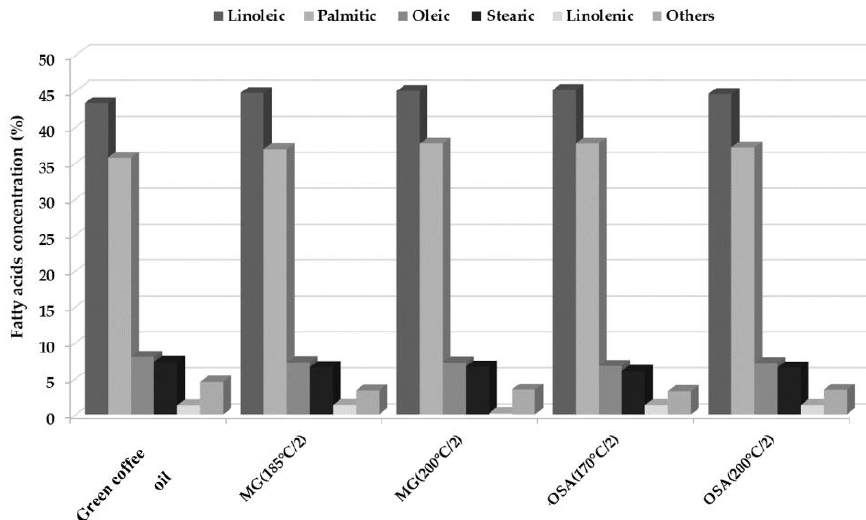
Figure 4. Fatty acid profile of the green coffee oil after one day of extraction, and microencapsulates with the higher peroxide index after 30 days of storage in 32% RH at 25 °C.